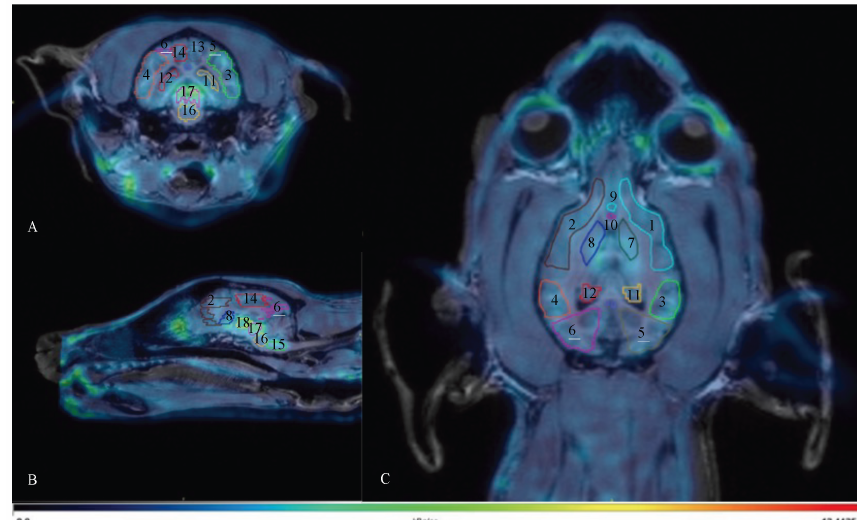
Figure 2. Transversal ( A ), sagittal ( B ), and dorsal ( C ) fusion image ([ 11 C]DASB PET scan and MRI). 1: right frontal cortex, 2: left frontal cortex, 3: right temporal cortex, 4: left temporal cortex, 5: right occipital cortex, 6: left occipital cortex, 7: right caudate nucleus, 8: left caudate nucleus, 9: presubgenual anterior cingulate cortex, 10: subgenual anterior cortex, 11: right hippocampus, 12: left hippocampus; 13: right parietal cortex, 14: left parietal cortex, 15: medulla oblongata, 16: pons, 17: midbrain, 18: left